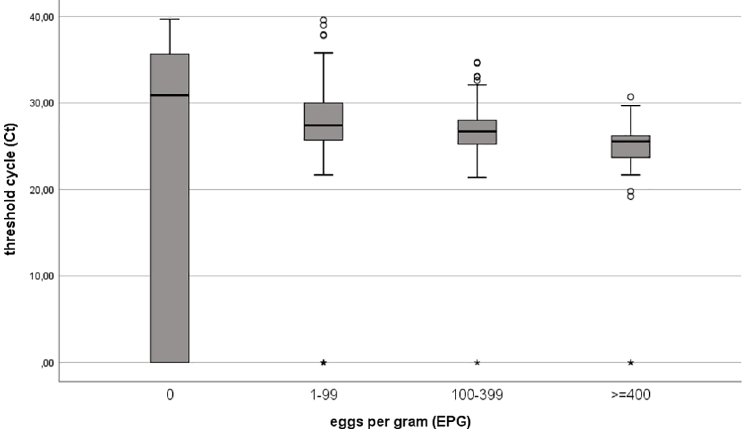
Fig 3. Threshold cycle (Ct) values of S . mansoni specific real-time PCR correlate negatively with the level of schistosome infection (determined by the Kato Katz method, expressed in eggs per gram (EPG)) (Spearman’s correlation coefficient = -0.32; p < 0.001). S . mansoni real-time PCR-positive samples show a decreasing Ct value with increasing egg count